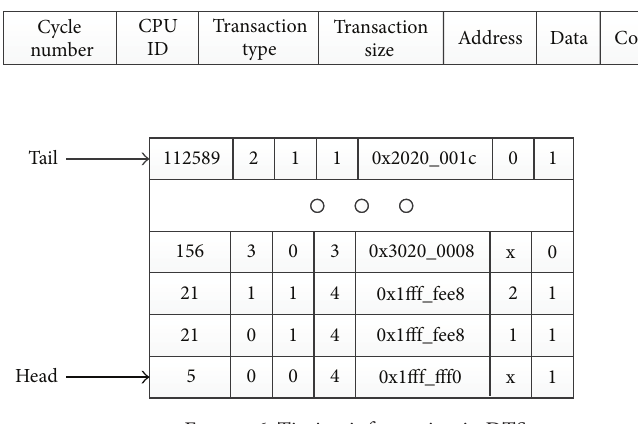
Figure 6: Timing information in DTS.